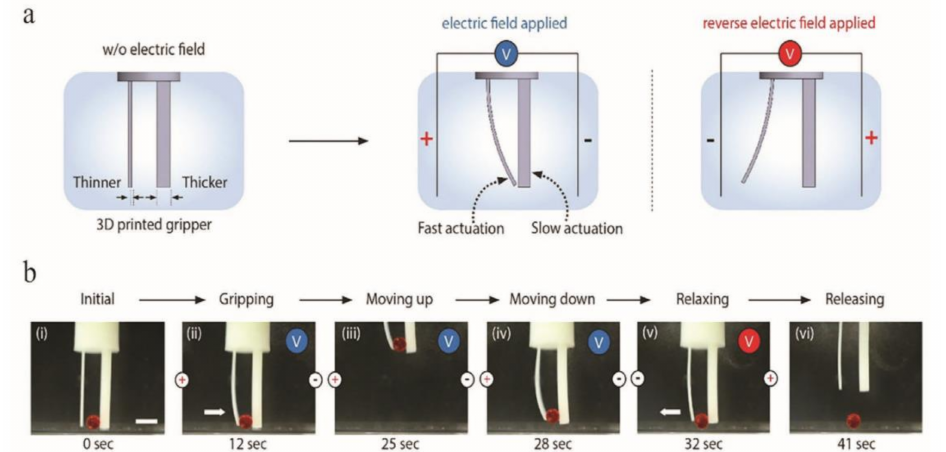
Figure 7. Deformation diagram of the electrically stimulated soft body robot. ( a ) Schematics of a gripper consisting of two beams with different thicknesses. ( b ) Gripping an object by applying the electric